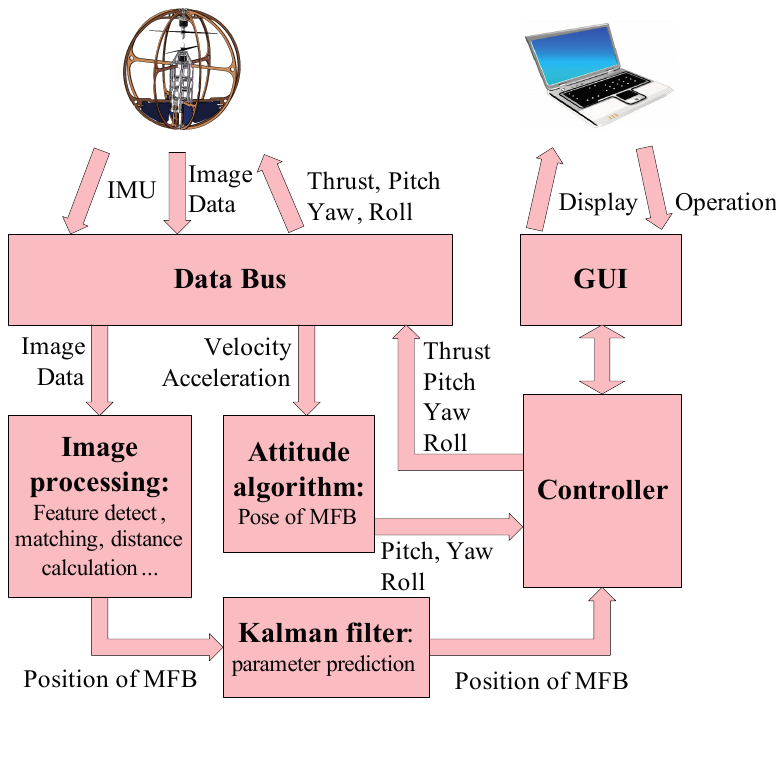
Figure 7. Software architecture.